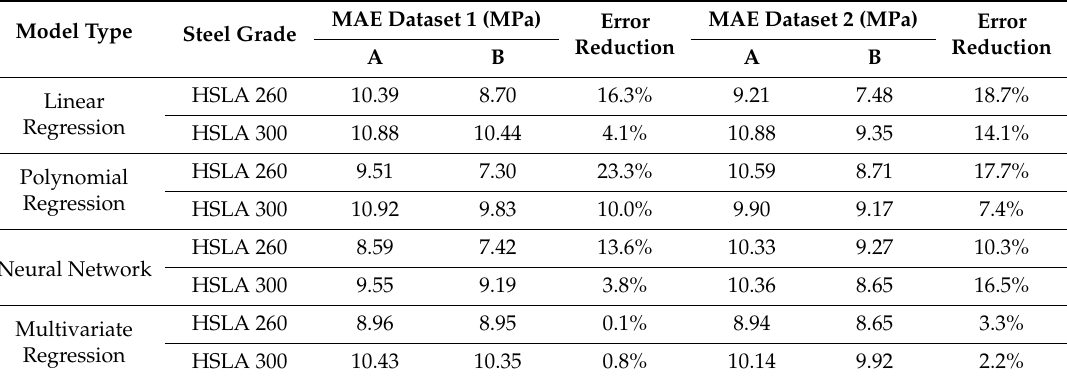
Table7. Resultsofthedi ff erentmodelsanddatasetsforthepredictionofyieldstrengthYS.Theminimum error values for each model and steel grade are marked in